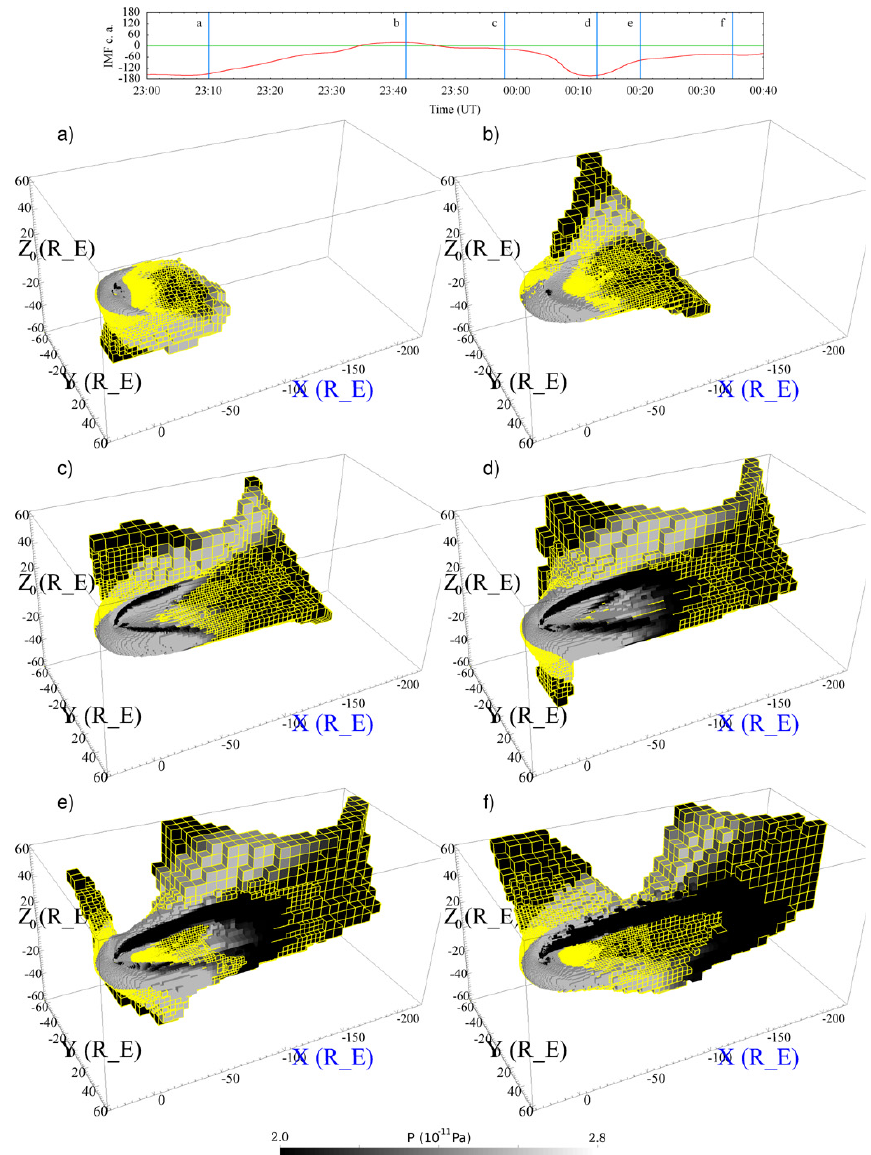
Fig. 11. Classification of cells in the simulation by their magnetic field topology is shown by the visible grid as in Fig. 8. Color coding shows the thermal pressure. The magnetic field topology, thermal pressure and clock angle in the simulation are shown during and after the fourth AE intencification at (a) 23:10, (b) 23:42, (c) 23:58, (d) 00:13, (e) 00:20 and (f)